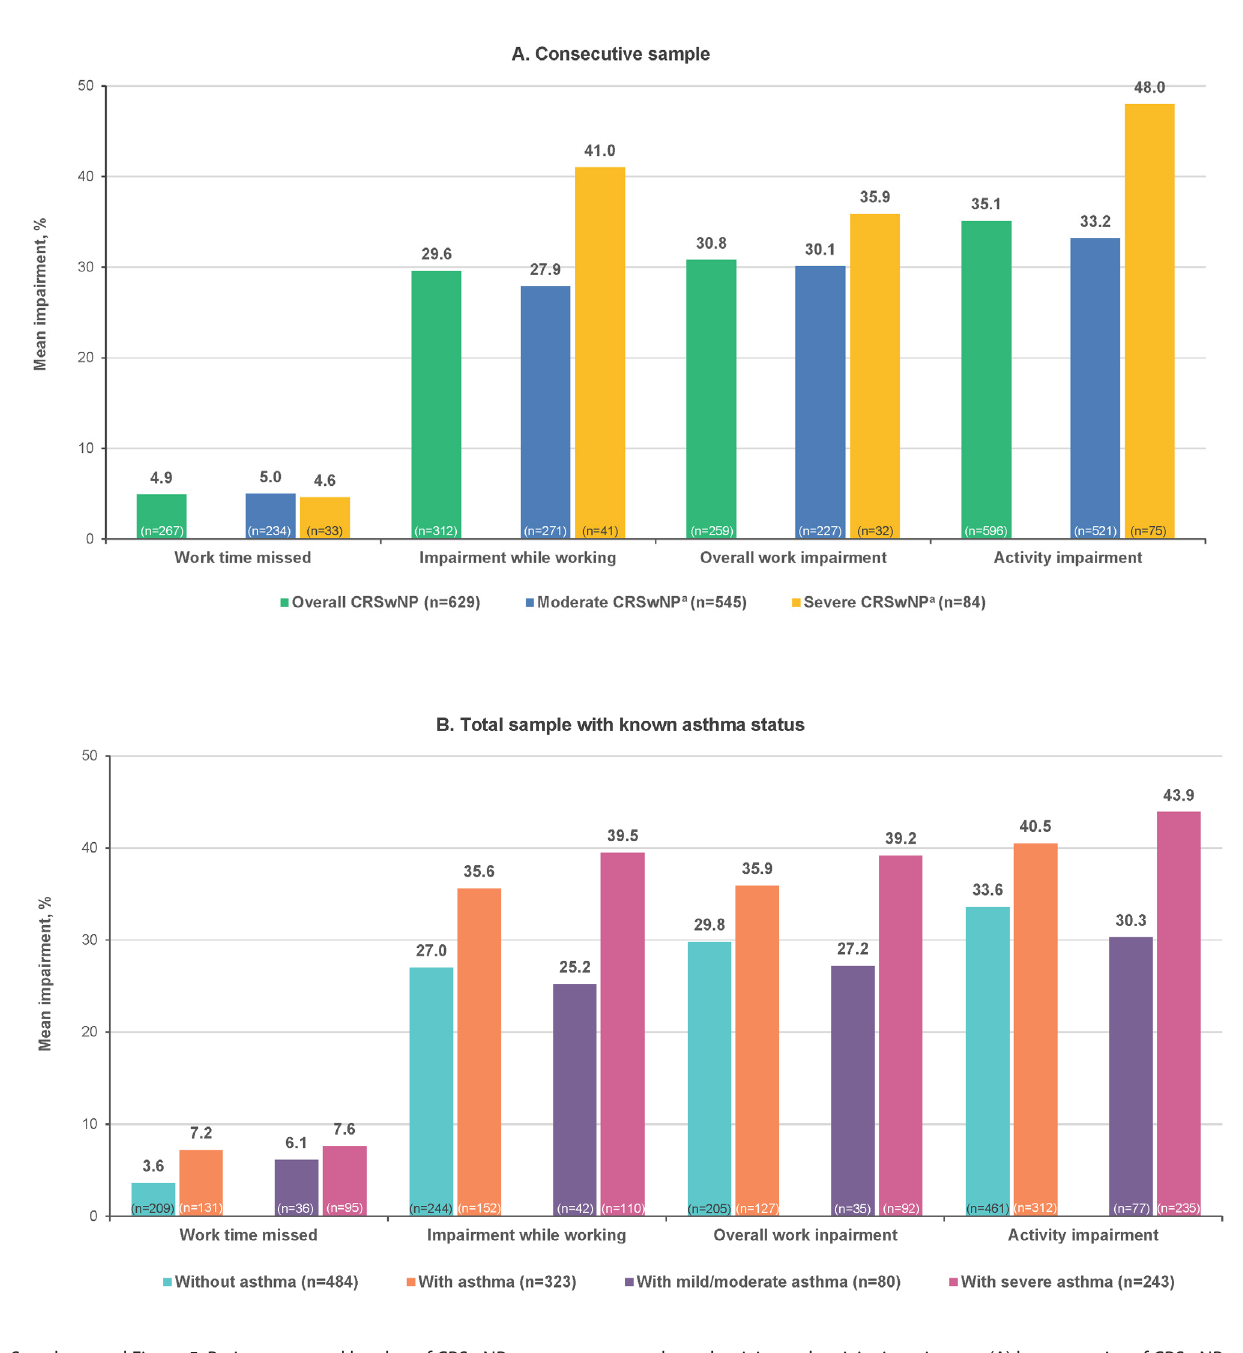
Supplemental Figure 5. Patient-reported burden of CRSwNP symptoms on work productivity and activity impairment, (A) by categories of CRSwNP severity (consecutive sample) and (B) by categories of asthma comorbidity (total sample with known asthma status and asthma severity). a CRSwNP severity determined by physician for each patient based on physician’s clinical expertise and provided guidance to follow the European Position Paper on Rhinosinusitis and Nasal Polyps guidelines (2,10) and NP size scoring